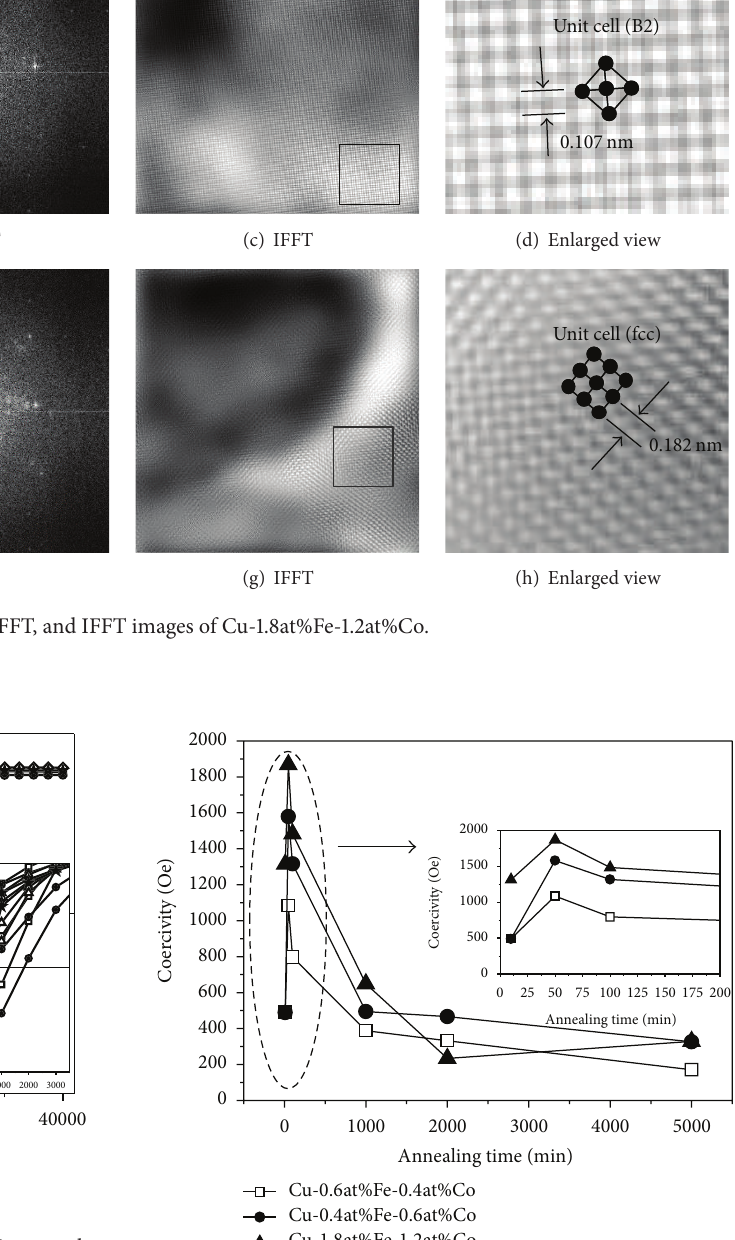
Figure 5: Hysteresis loops of Cu-1.8at%Fe-1.2at%Co samples annealed at 973 K. Figure 6: Temporal changes of coercivity in Cu-Fe-Co alloys annealed at 973